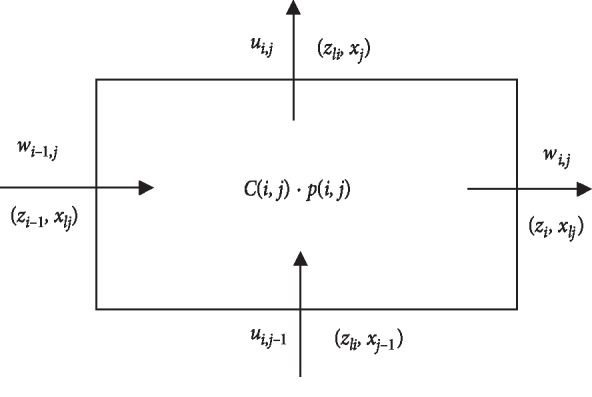
A typical MAC cell.